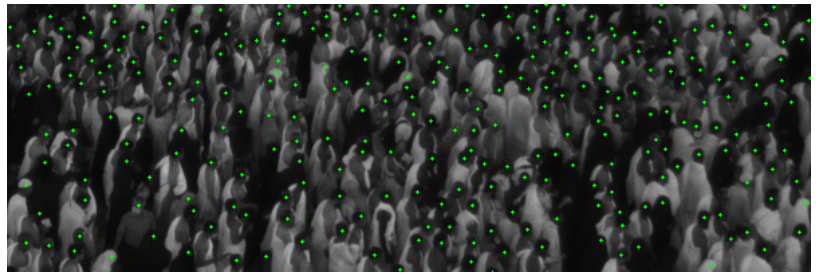
Figure 4. Patch with ground-truth dotted